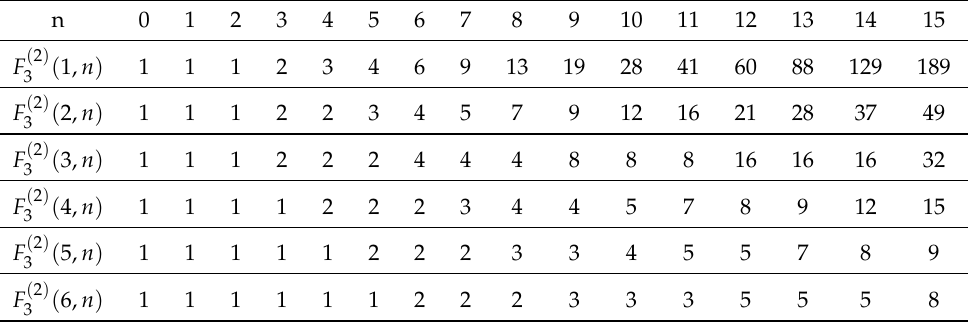
Table 2. Numbers F